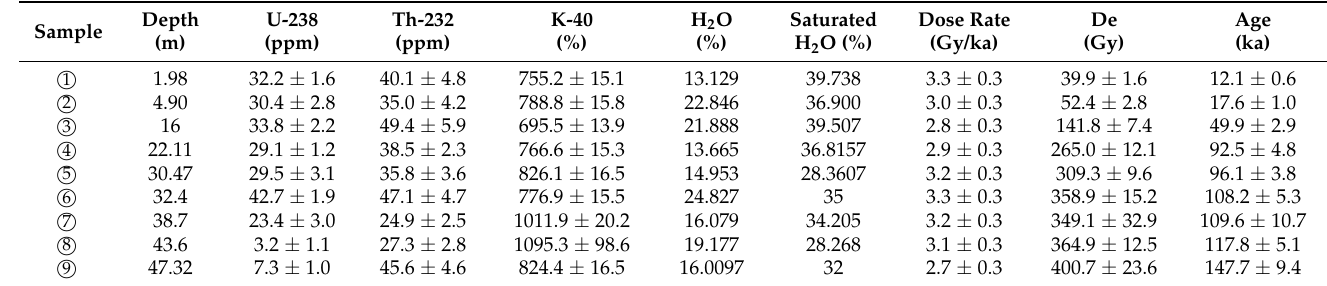
Table 1. OSL data of the SHBZK-1 core in north Hebei Plain.